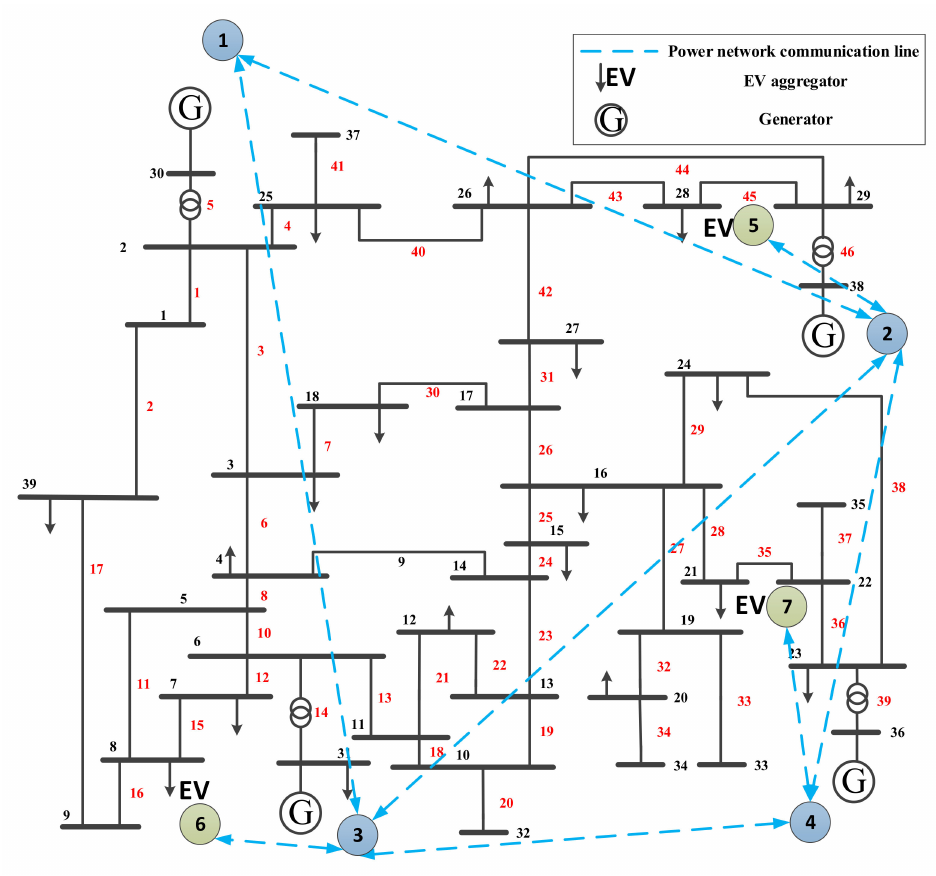
Figure 9. The communication topology diagram corresponding to the 39-node test system.